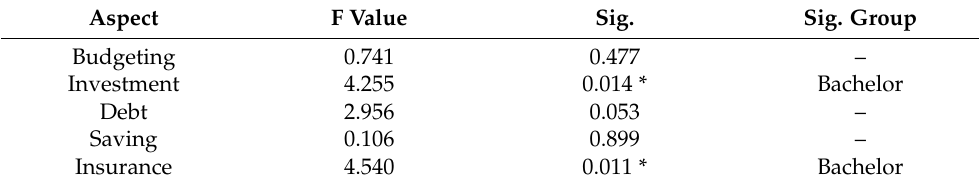
Table 12. Differences according to educational level using the ANOVA test ( n = 886 **). Aspect F Value Sig. Sig. Group Budgeting 0.741 0.477 Investment 4.255 0.014 * Bachelor Debt 2.956 0.053 Saving 0.106